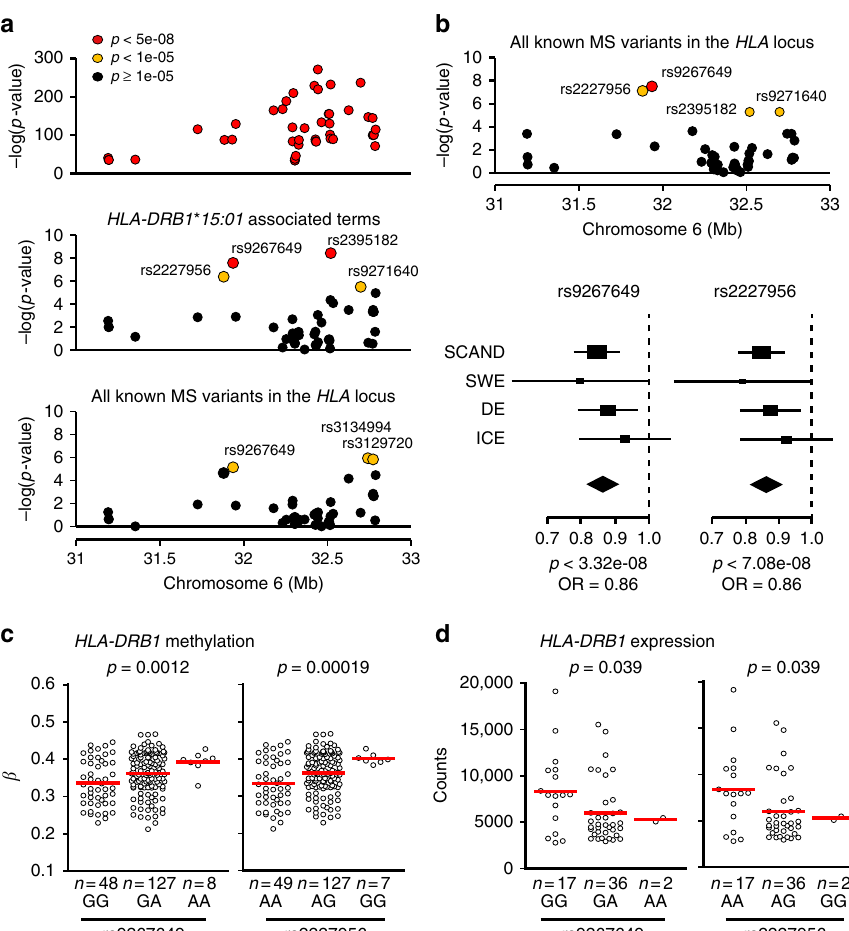
Fig. 6 Association of methylation-mediated SNPs with multiple sclerosis (MS). a Association between SNPs and MS in the Scandinavian cohort (SCAND, 8172 cases and 13,263 controls) after adjustment for four PCAs (upper panel), the DRB1*15 : 01 associated terms (middle panel) and all 13 established MS risk variants in the HLA locus 5 (lower panel) (for details see Methods). b Association between SNPs and MS based on meta-analysis of SCAND and three additional cohorts from Sweden (SWE), Germany (DE), and Iceland (ICE) (upper panel, 14,259 cases and 171,347 controls) and Forest plots (lower panel) representing odds ratios (OR, square, proportional to weight) and associated con fi dence intervals for each cohort and the summary measure (diamond) for the signi fi cant (rs9267649) and suggestive (rs2227956) SNPs, with dotted vertical line of no effect. a , b The – log 10 ( p -value) of 47 out of 50 SNPs and their position on chromosome 6 are given on the y - and x -axis, respectively. Colors of circles correspond to different thresholds of statistical signi fi cance, red: p -value < 5 × 10 − 8 (genome-wide signi fi cance), orange: 1 × 10 − 5 < p -value < 5 × 10 − 8 (suggestive signi fi cance) and black: p -value ≥ 1 × 10 − 5 (non- signi fi cant). c Methylation values at DMR3 (exon 2) of HLA-DRB1 gene in DRB1*15 : 01 heterozygous MS patients and healthy controls ( n = 183) strati fi ed according to the rs9267649 (left panel) and rs2227956 (right panel) genotype. d HLA-DRB1 gene expression in DRB1*15 : 01 heterozygous MS patients and non-MS controls ( n = 55) strati fi ed for the rs9267649 (left panel) and rs2227956 (right panel) genotype. c , d Signi fi cance was estimated using linear regression (for details see